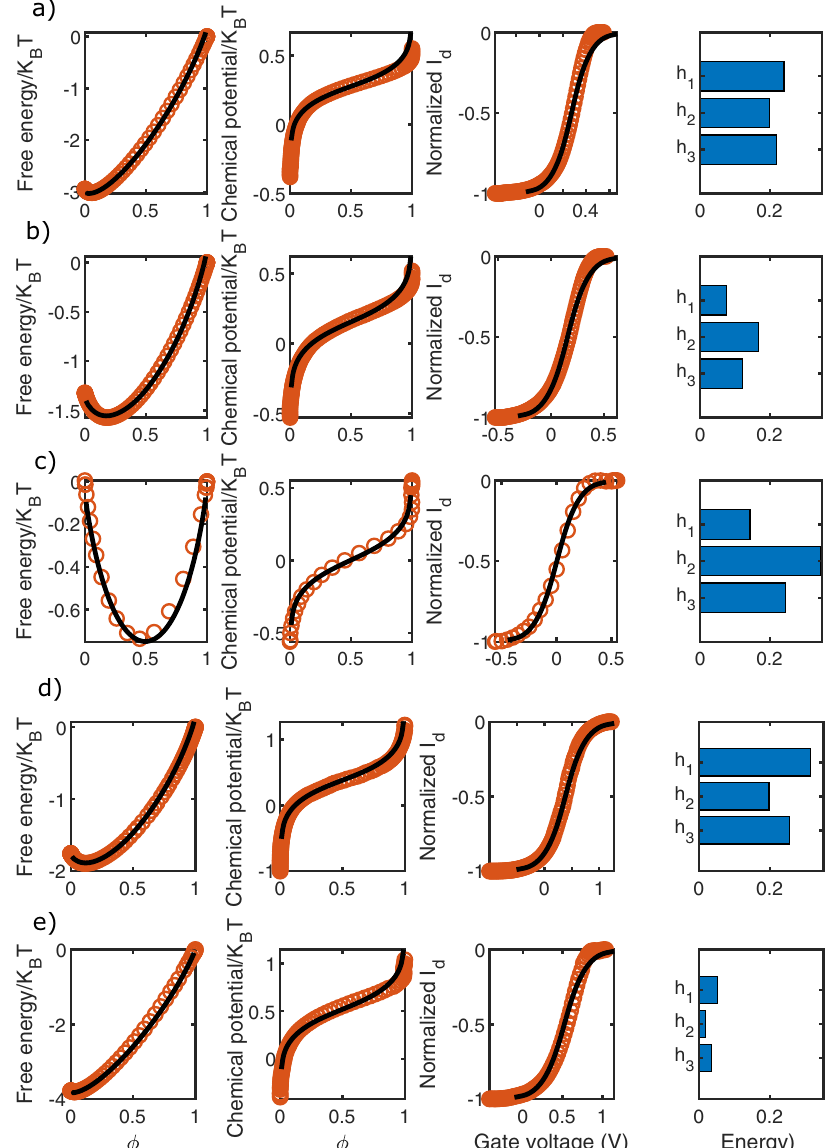
Fig.4|Quanti fi cationofenthalpy. Investigationofthechemicalpotentialandfree energy underlying the transfer characteristics of an OECT immersed in a 100mM NaCl aqueous solution, b 100mM KCl aqueous solution, c ionic liquid, d 100mM LiClO 4 inbutanol,and e 100mMLiClO 4 inwater.Experimentallydeterminedcurves